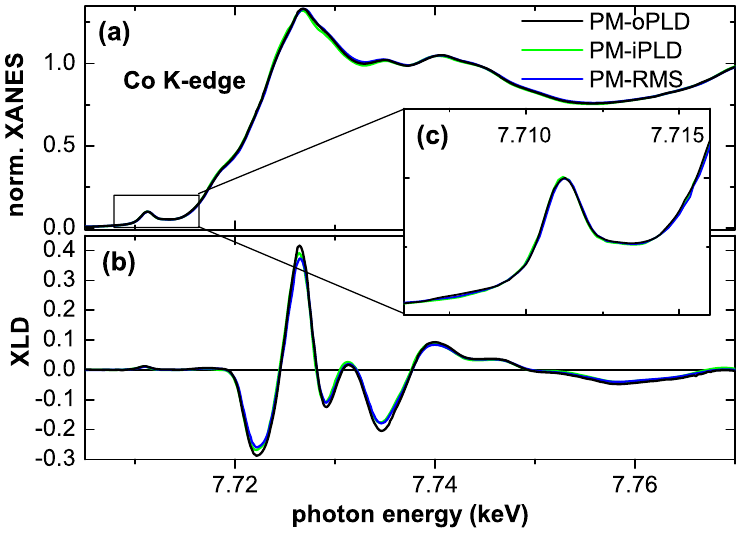
(a) normalized XANES at the Co K -edge of three different PM Co:ZnO samples and (b) the respective XLD signal. (c) enlarges the pre-edge feature of the XANES (see